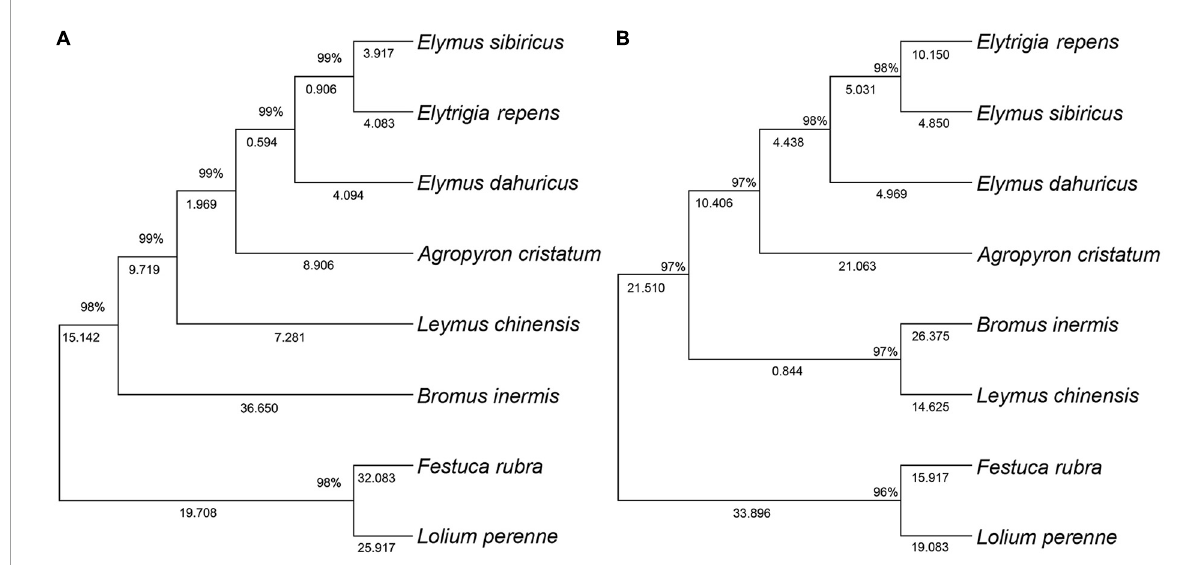
FIGURE2 Topology resulting from Neighbor-Joining analysis of ITS and 3-cpDNA in the seven genera of Gramineae. One ITS dataset (A) , 3-cpDNA dataset ( matK , rbcL, and trnL - F ) (B) .